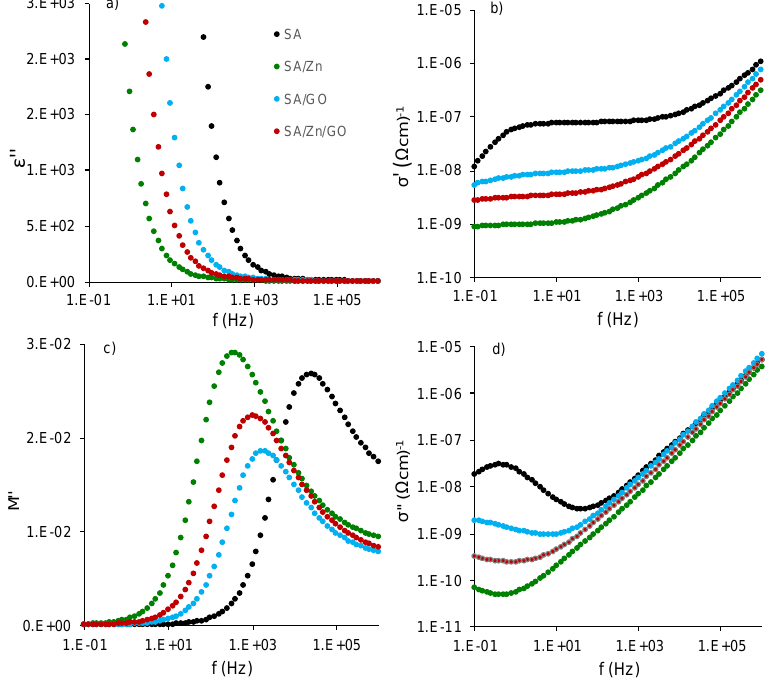
Figure 6. Frequency dependence obtained at 20 ◦ C from the dielectric relaxation spectroscopy (DRS) spectra. ( a ) Imaginary part of the permittivity; ( b ) real part of the conductivity, ( c ) imaginary part of the electric modulus, ( d ) imaginary part of the